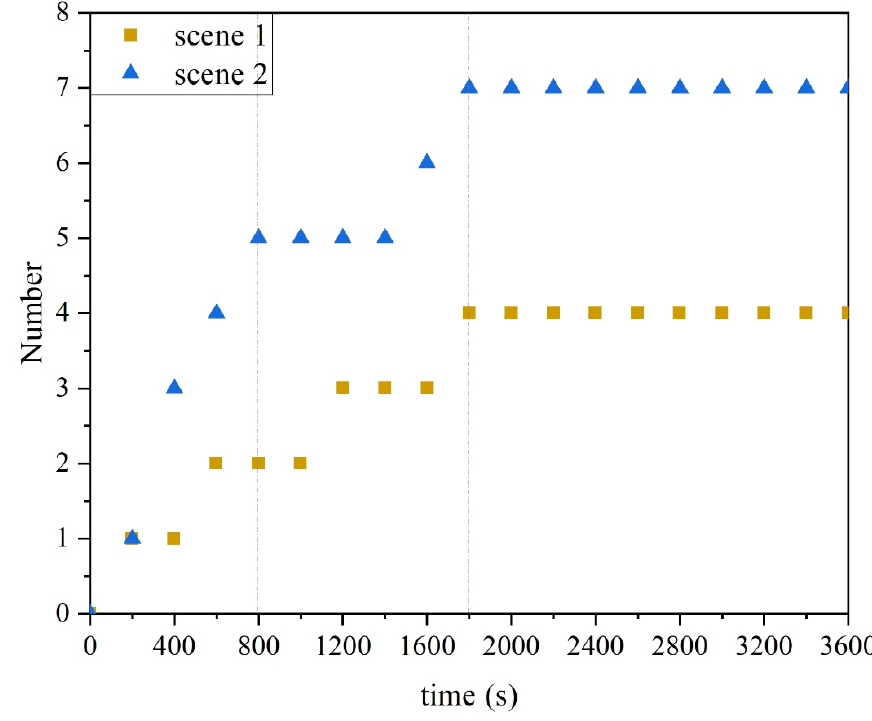
Figure 20. The number of dwellings on fire in different street patterns over time.